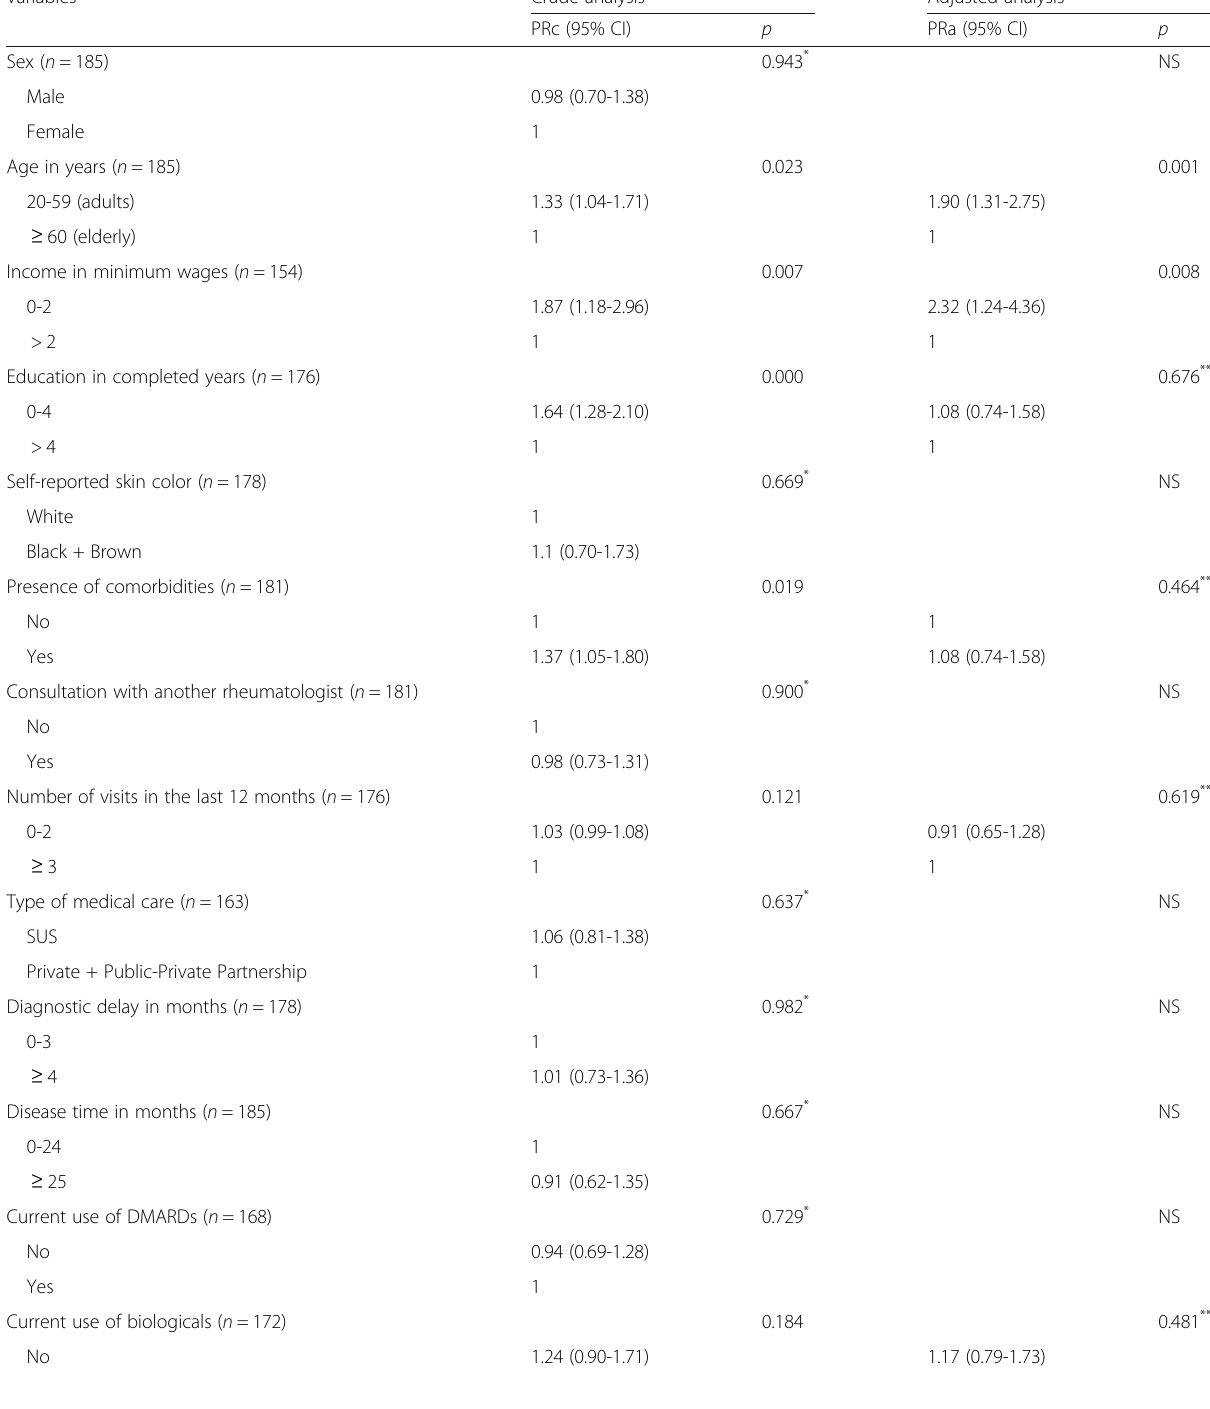
Table 2 Crude and adjusted Poisson regression analyses of the prevalence of working patients with rheumatoid arthritis as a function of independent variables in Blumenau, Santa Catarina state, Brazil,